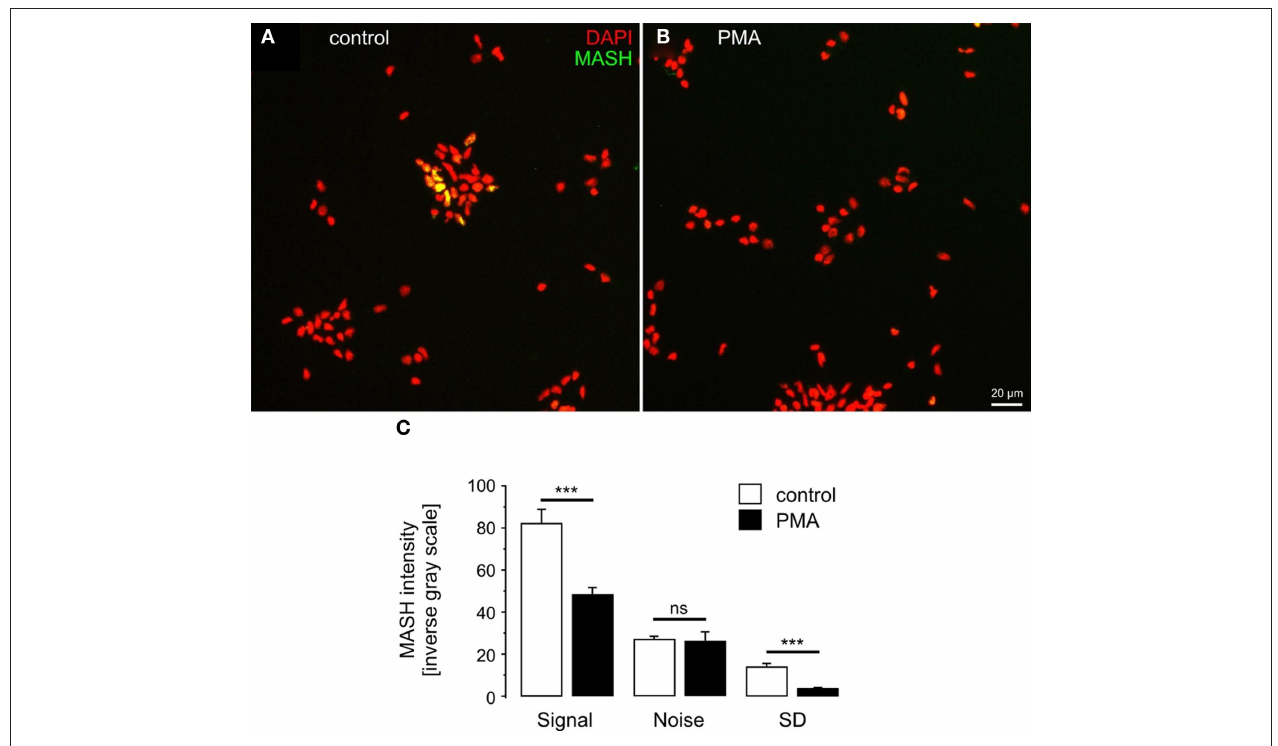
Figure 8 | Phorbol 12-myristate 13-acetate induces Mash1 suppression in primary cortical cells. MASH1 expression in d.i.v. 2 control (A) and PMA-treated (B) cortex cells is shown. (C) Quantitative analysis of Mash1 intensity. Note that increasing values represent increasing fluorescence intensities. The standard deviation (SD) was used as a measure of cellular heterogeneity of Mash1 expression. n = 6 cultures; *** p < 0.001; ns, not